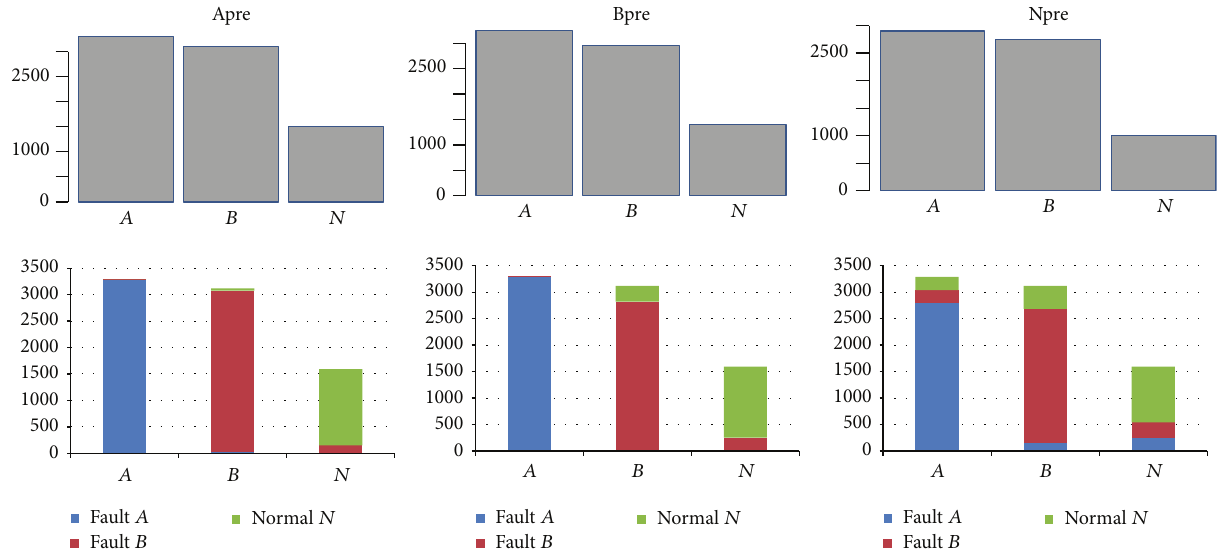
Figure 10: Using three models to diagnose the satellite remote sensing data, respectively.